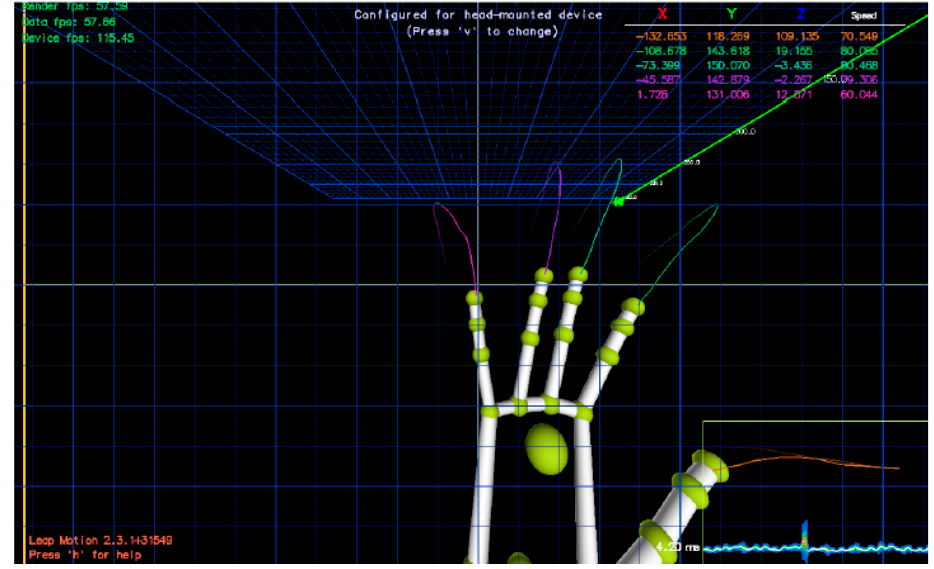
Figure 1. Leap Motion hand model in 3D.